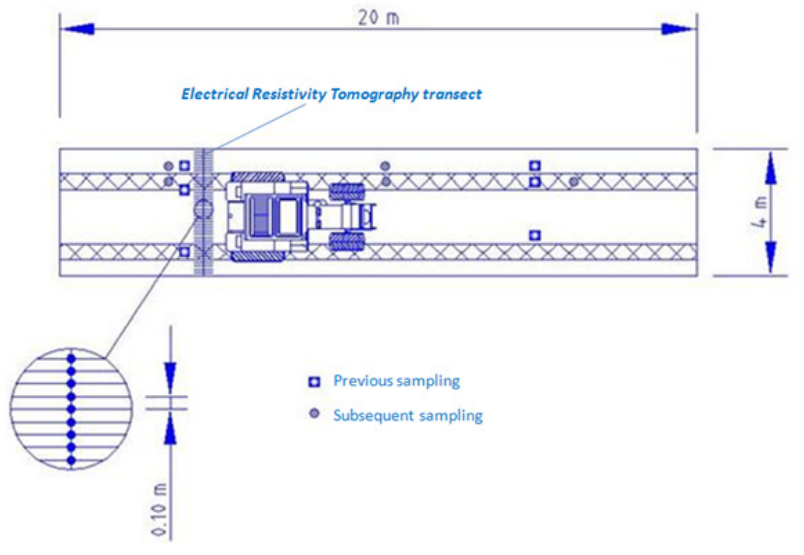
Figure 2 : Scheme of the tomography assessment and soil sampling within the experimental